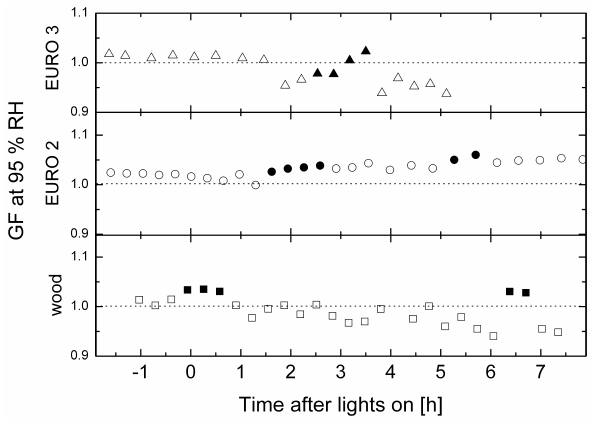
Fig. 10. GF of wood combustion particles and soot particles from the EURO 2 transporter and EURO 3 passenger car measured with an HTDMA. Filled symbols illustrate the GF of 200nm sized soot particles with a humidity pre-treatment, which should eliminate fur- ther restructuration in the actual growth